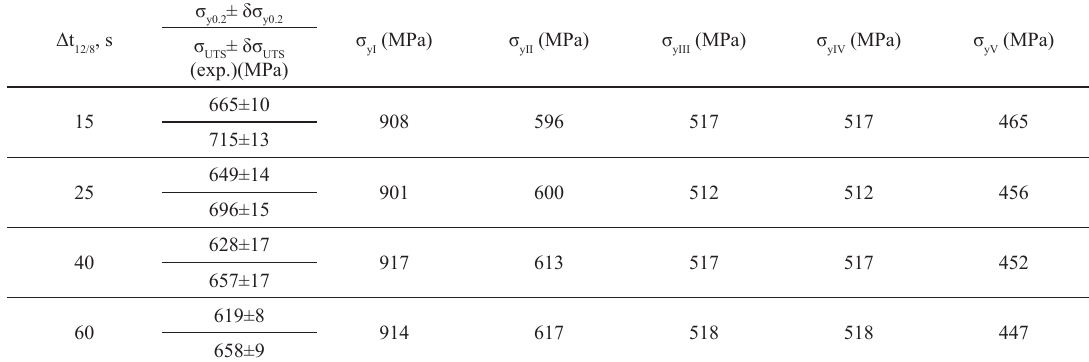
and σ values of the as- y0.2 UTS